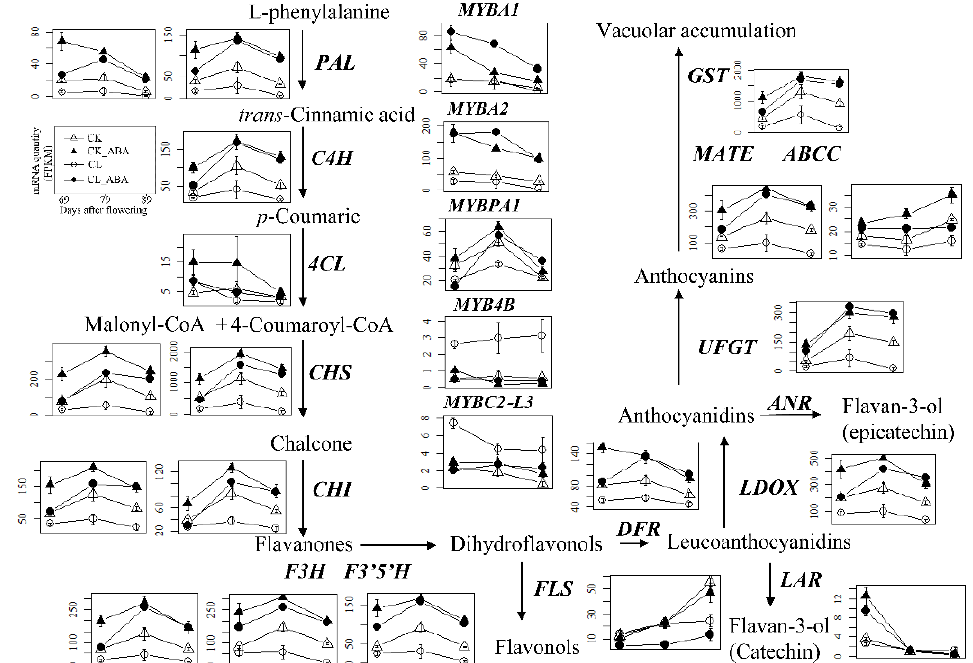
Figure 2. The mRNA quantities of genes related to anthocyanin biosynthesis at the first three devel- opmental stages under different carbon supplies and exogenous ABA treatments. PAL : pheammo ‐ nia ‐ lyase; C4H : cinnamate 4 ‐ hydroxylase; 4CL : 4 ‐ coumarate ‐ CoA ligase; CHS : chalcone synthase;